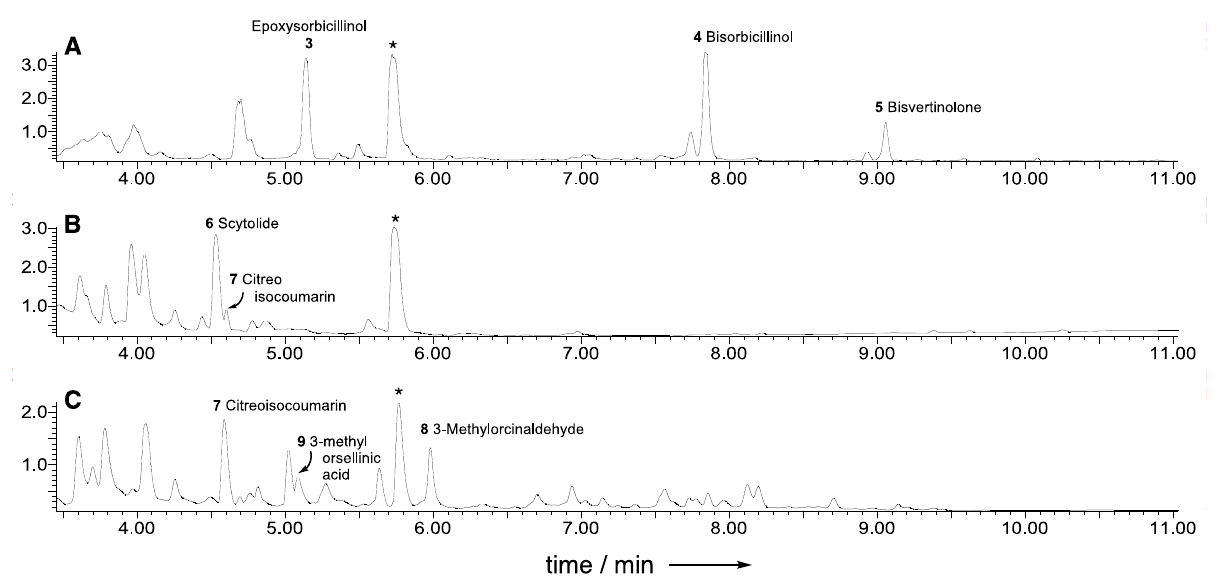
Figure 2. LC–MS traces of T. reesei strains grown in on DPY + 1% glucose media. ( A ), T. reesei QM6a · ∆ tmus53 · ∆ pyr4 ; ( B ), T. reesei QM6a · ∆ tmus53 · ∆ pyr4 · ∆ sorBC ; ( C ), T. reesei QM6a · ∆ tmus53 · ∆ sorBC · P · aspks1 . * = unrelated pdc